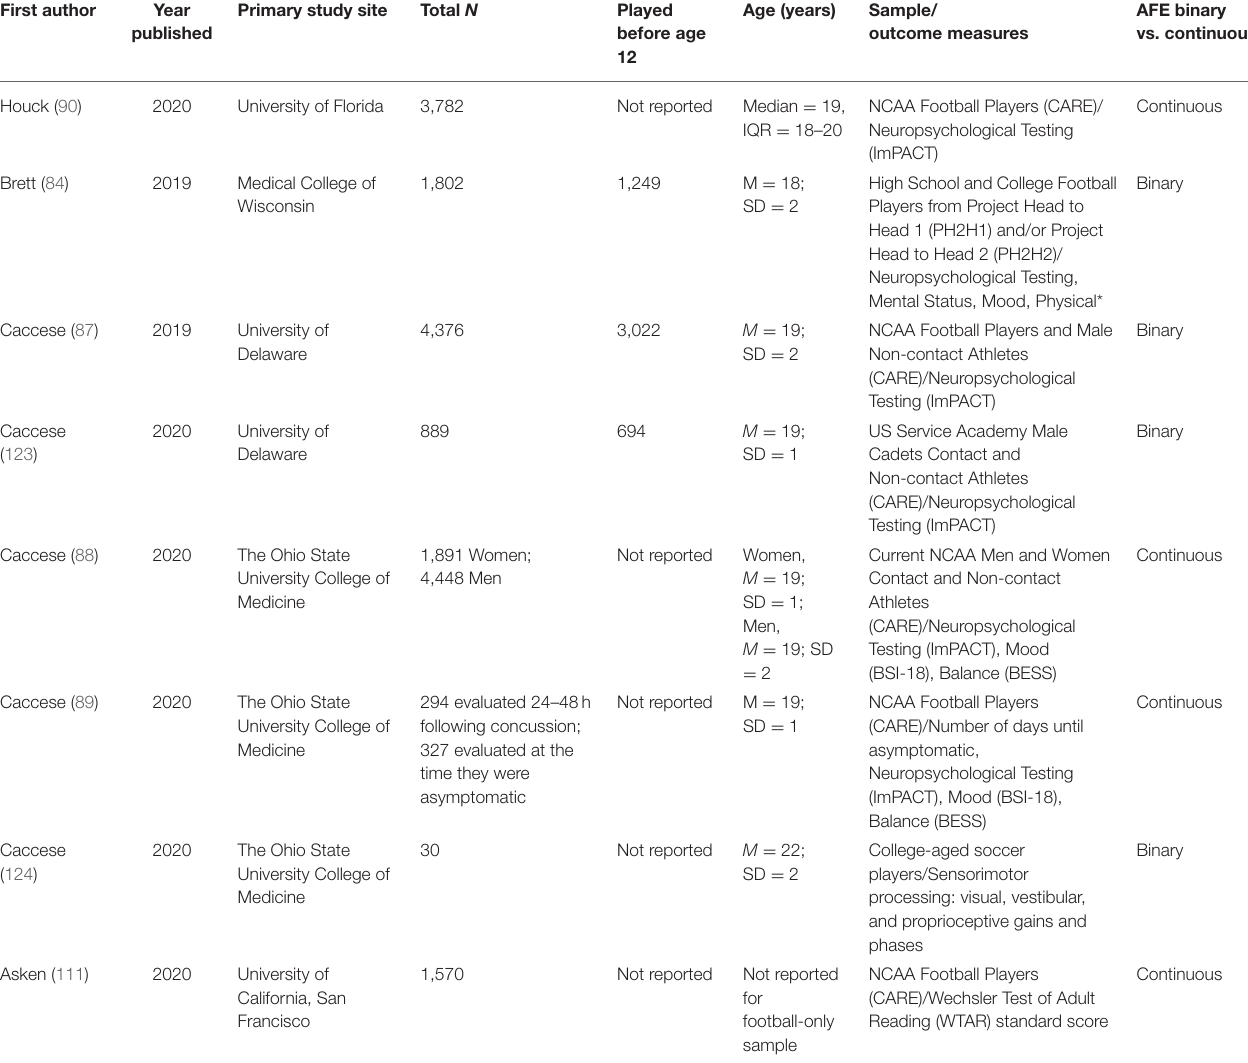
TABLE 2 | Summary of studies of current